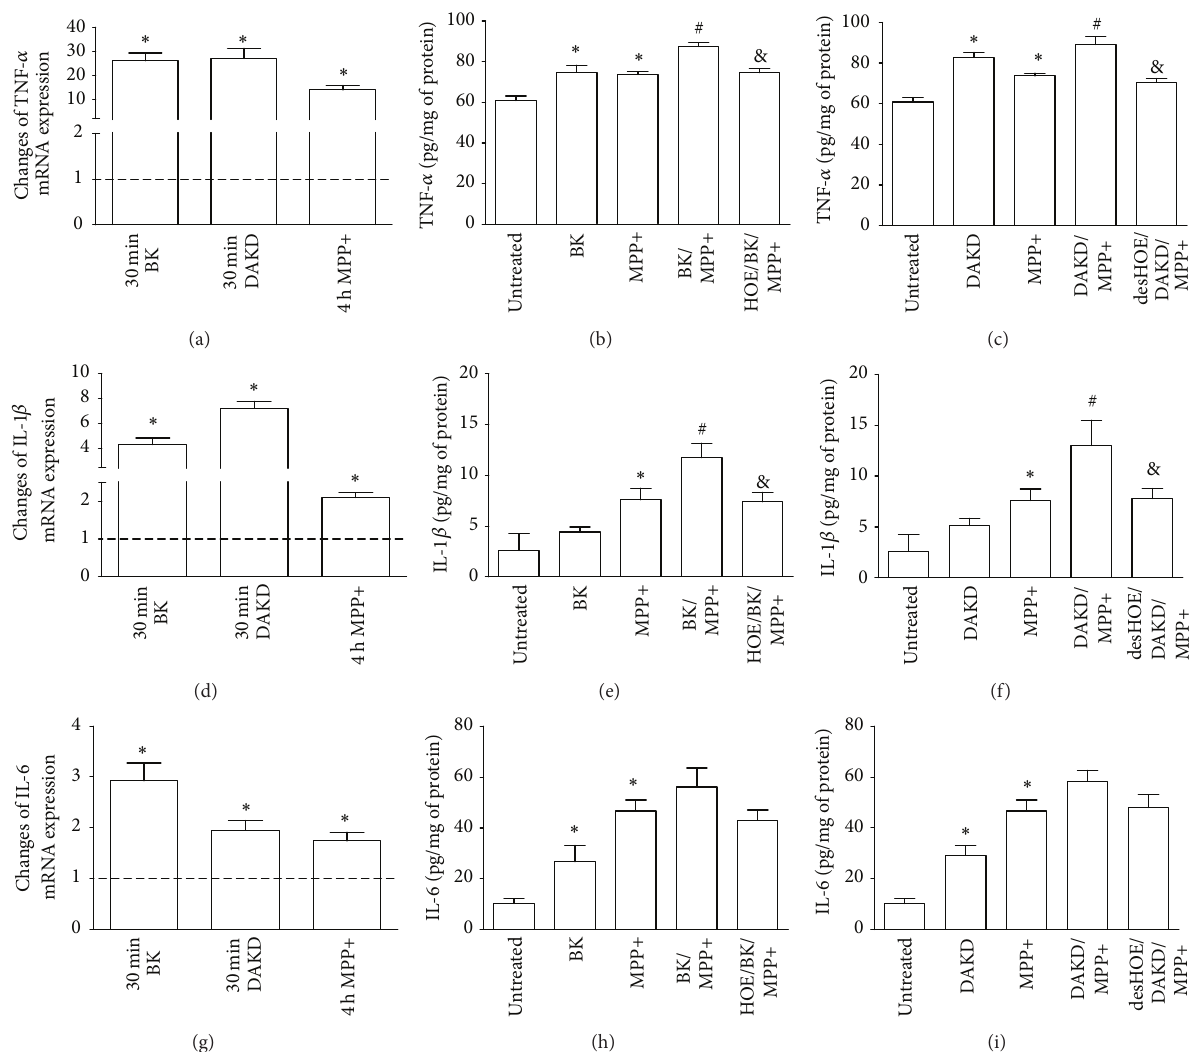
Figure 4: The induced expression of proinflammatory cytokines in differentiated SK-N-SH cells stimulated with kinin peptides. Confluent cell cultures were treated with 1 𝜇 M BK or 1 𝜇 M DAKD without or in the presence of 2.5 mM MPP+ as described in Materials and Methods. ThemRNAexpressionandproteinproductionforTNF- 𝛼 (a,b,c),IL-1 𝛽 (d,e,f),andIL-6(g,h,i)wereanalyzedbyReal-TimePCRandELISA. ThefiguresshowthepercentagechangesofmRNAexpressionascomparedwithcontrolsamples,assumedtopossess100%expression(dashed line) from at least three experiments performed in duplicate. The amount of released protein was normalized to the amount of sample protein and the results are shown as mean values ± SD from three experiments performed in triplicate. ∗ 𝑃 < 0.05 versus untreated cells; # 𝑃 < 0.05 versus MPP+-stimulated cells; & 𝑃 < 0.05 versus cells stimulated with kinin peptides and